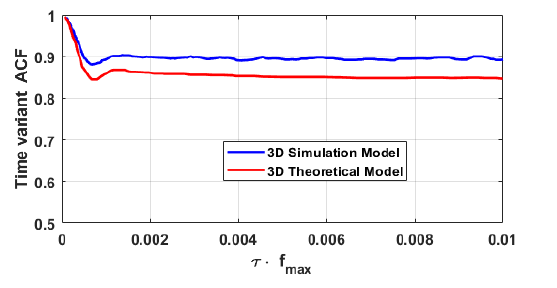
Figure 6. The absolute values of the time-variant ACF of the 3D theoretical model, the 3D simulation model in open space scenario.